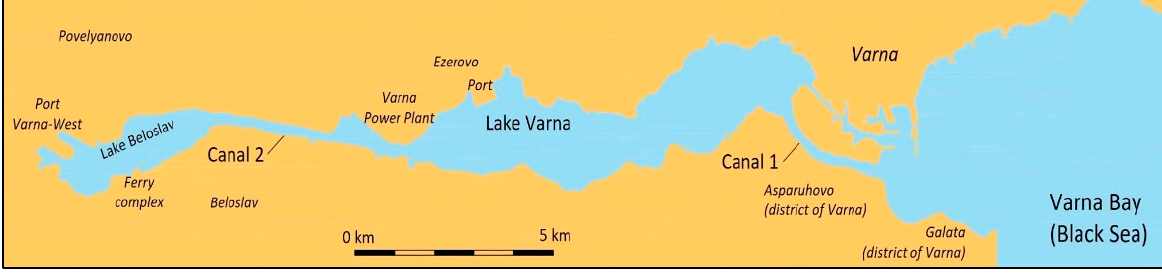
Figure 1. Varna port canals.